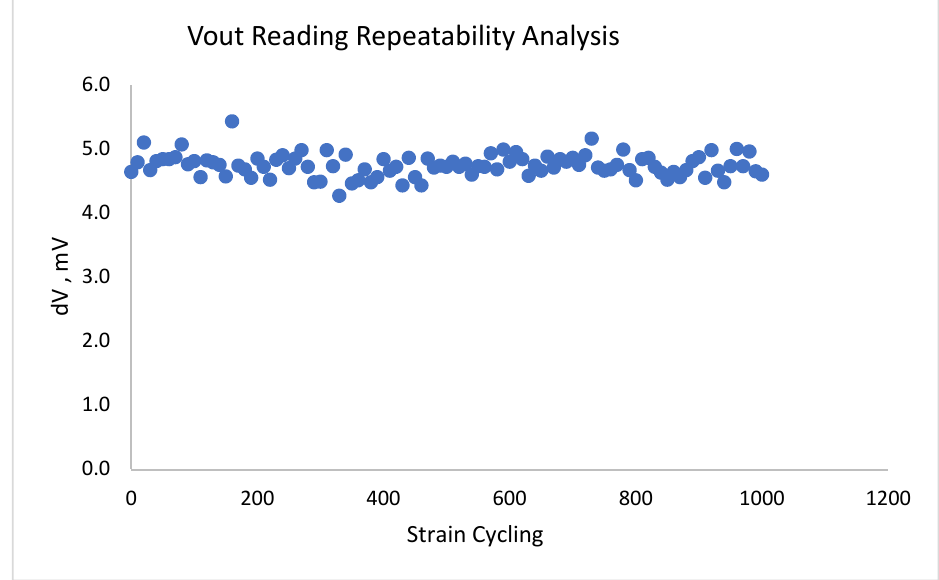
Figure 5. Results of repeatability tests, 1000 cycles.